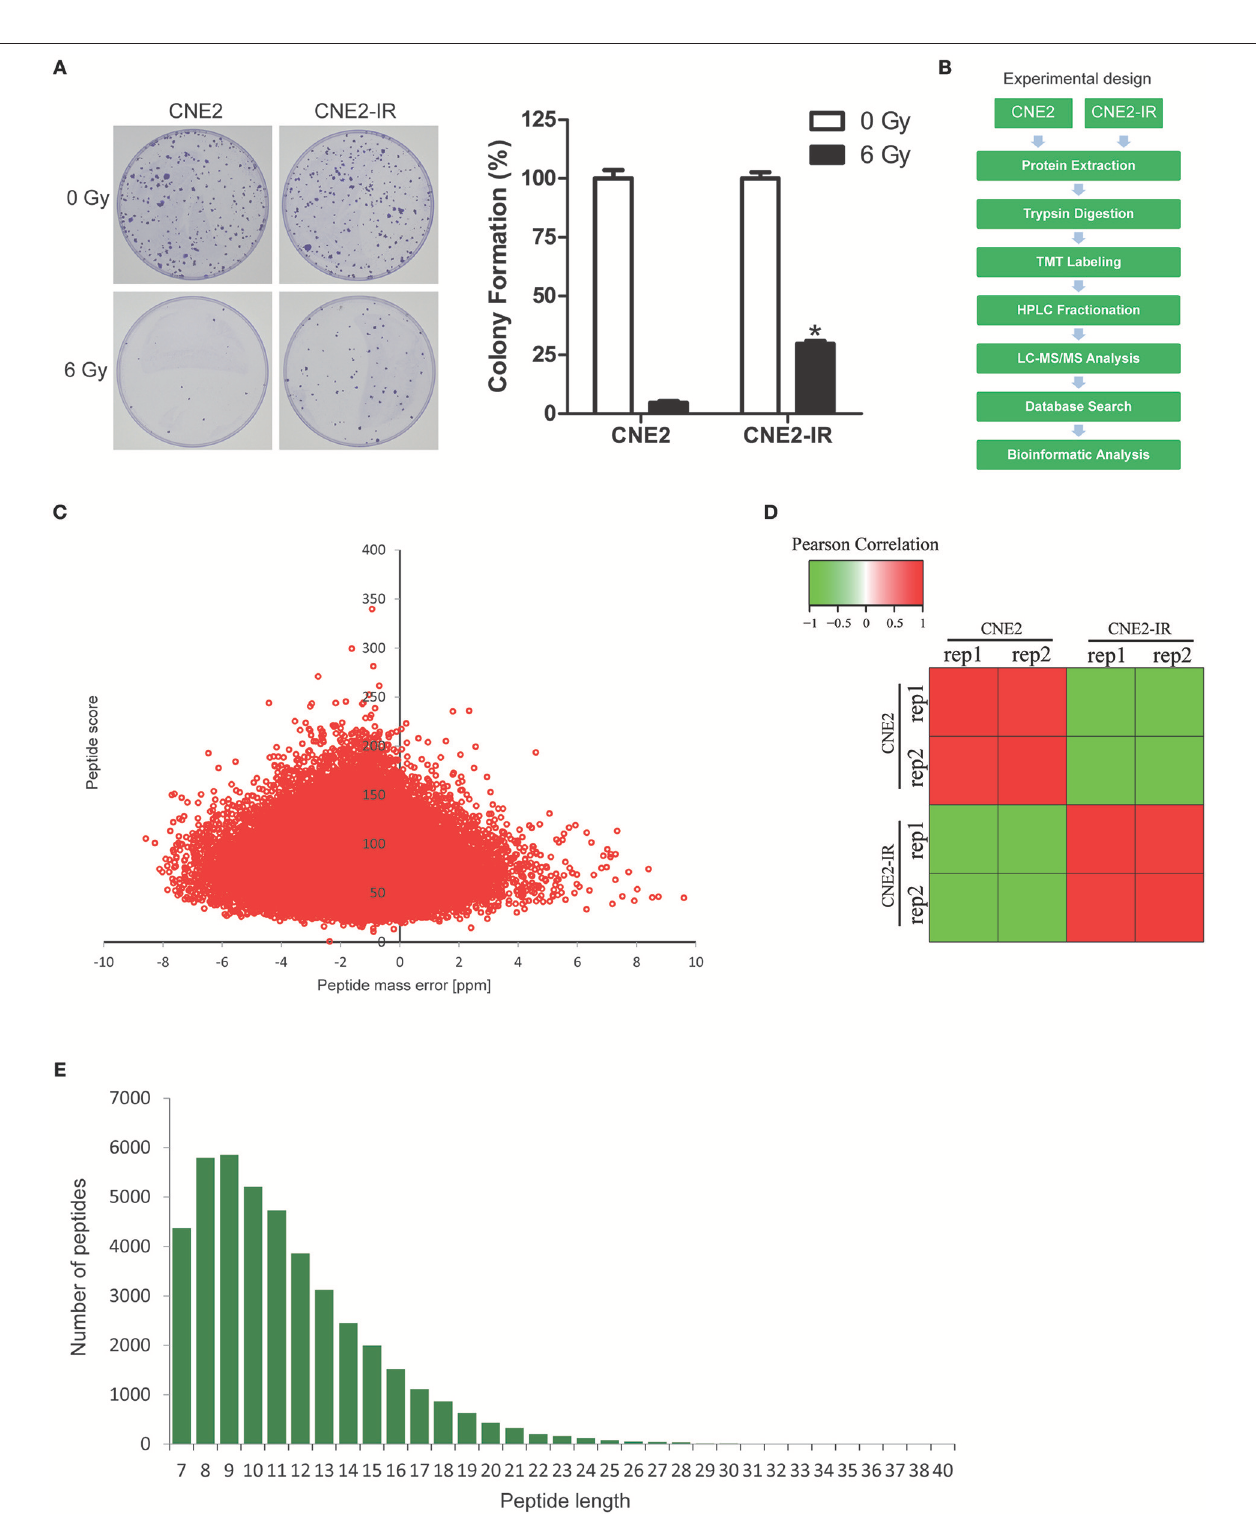
FIGURE 1 | Quantitative proteomic analysis on CNE2 and its radioresistant subline CNE2-IR. (A) Clonogenic survival analysis on the radiosensitivity of CNE2 and CNE2-IR. The colony formation in CNE2 or CNE2-IR without ionizing irradiation was regarded as 100%, respectively. CNE2-IR 6Gy vs. CNE2 6Gy, * P < 0.05. (B) Experimental scheme for the quantitative proteomic analysis on CNE2 and CNE2-IR. (C) QC validation of MS data. Mass error indicates distribution of all identified peptides. (D) Reproducibility of the quantitative proteomic analysis on CNE2 and CNE2-IR. (E) Peptide length distribution identified by quantitative proteomic analysis.